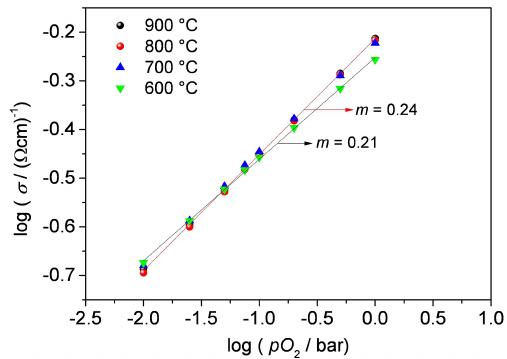
Figure 5. Double-logarithmic plot of conductivity vs. oxygen par- tial pressure for a BFT30 ADM-coated sensor. Please note that the curves of 700, 800, and 900 ◦ C can hardly be